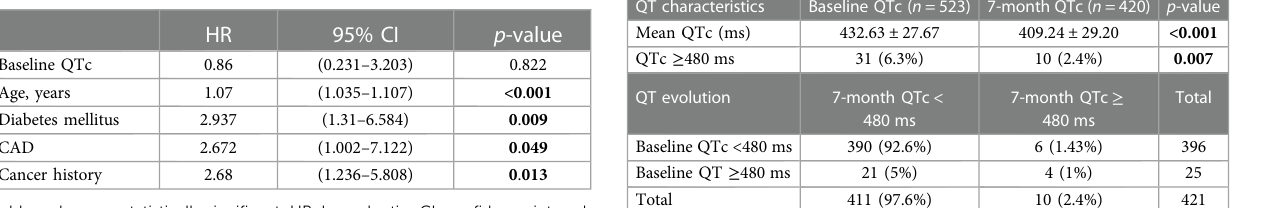
TABLE 4 Independent predictors of the composite endpoint (death, hospital readmission due to any cause, new arrhythmia) at 1 year after hospital discharge.